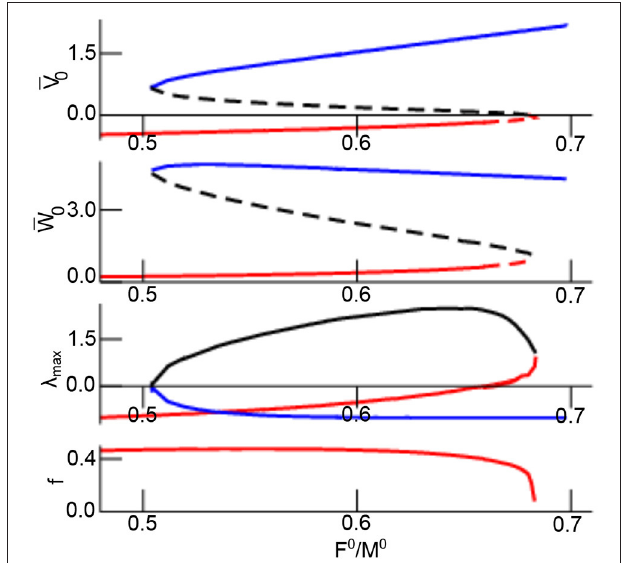
F 0 / M 0 . FIGURE 2 | Equilibria ¯ V 0 , ¯ W 0 and their stability as a function of γ = The top equilibrium is coded in blue line color, the center and bottom equilibrium is coded as black and red line in all panels. The lower panel shows the eigenfrequency of the bottom focus. The two top panels present stable equilibria by solid line and unstable equilibrium by dashed line. Further parameters are M 0 3.87, H 0 1.7, I 1 1.45, I 2 0.4 assuming iid-noise = = = = in both networks with D (1) n 0.2, D (2) 0.5. = =